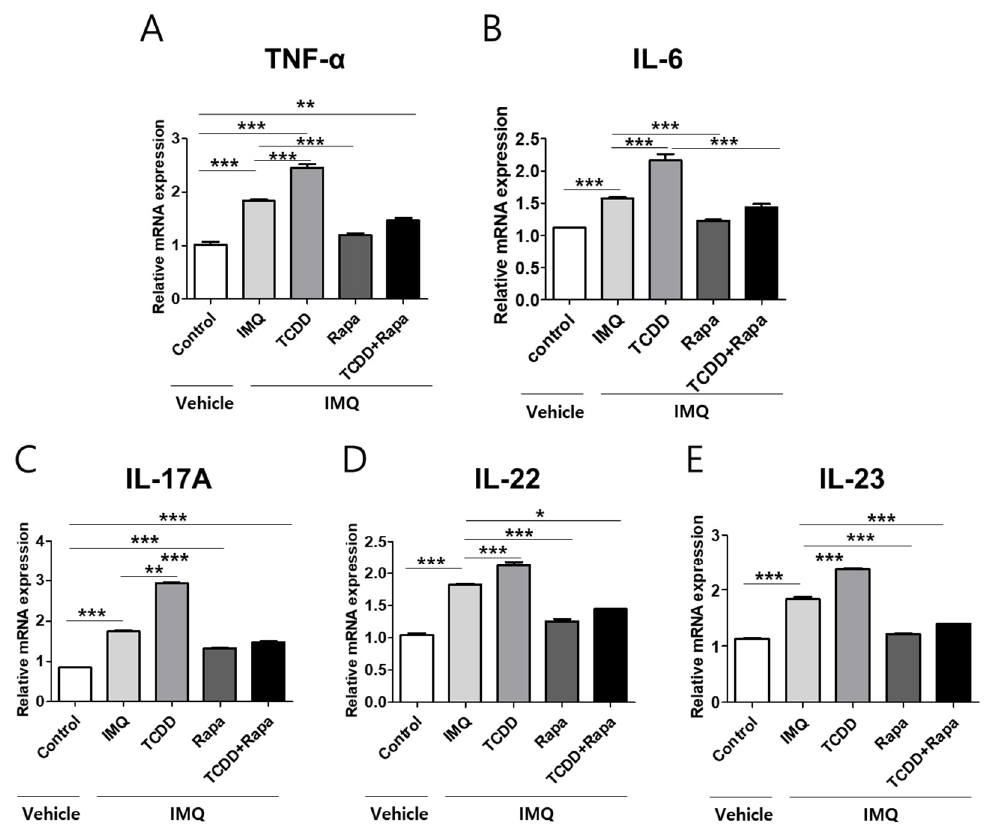
Figure 7. The effects of TCDD, rapamycin, or cotreatment of both on proinflammatory cytokine mRNA expression changes in the skin tissues of a psoriasis mouse model. ( A – E ) qPCR analysis of TNF- α , IL-6, IL-17A, IL-22, and IL-23 was performed in skin tissue from 5 different study groups ( n = 5 per group). Data represent mean ± SD of three independent experiments (each performed in duplicate). Statistical differences were determined by one-way analysis of variance (ANOVA) with Dunnett’s test. * p < 0.05; ** p < 0.01; *** p < 0.001. Rapa: rapamycin; IMQ: imiquimod.